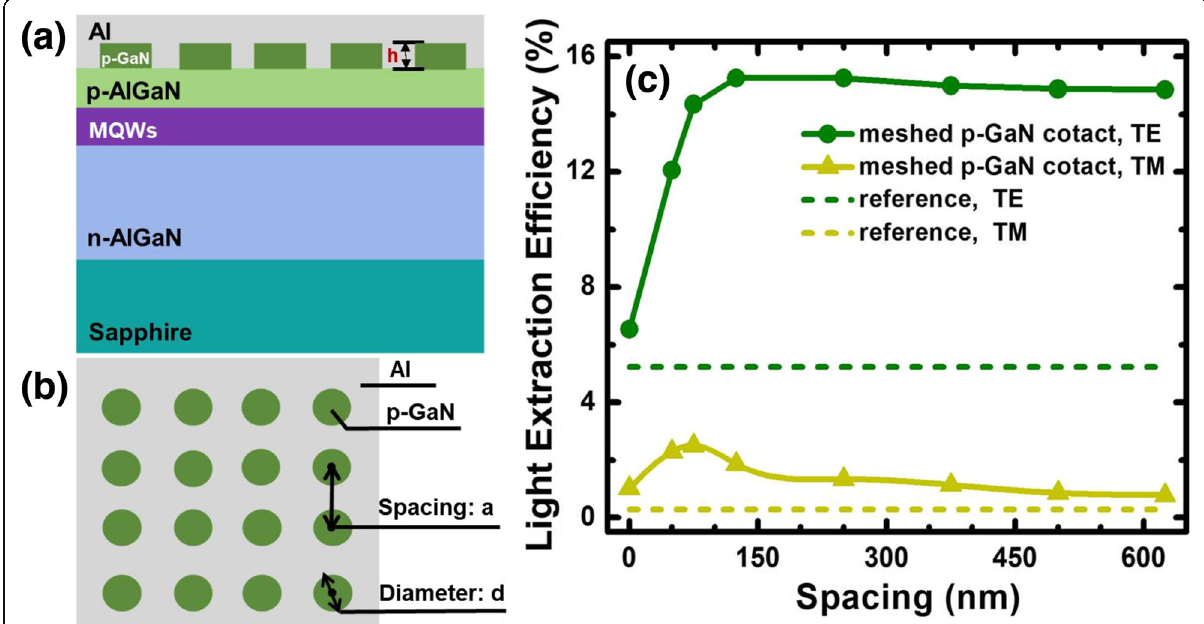
Fig. 2 a Schematic side view diagram of the flip-chip DUV LED with meshed p-GaN contacts. b Schematic top view diagram of meshed p-GaN contact distribution. c LEEs for DUV LED with the meshed p-GaN contacts as a function of the spacing of nanorods when the p-AlGaN thickness is